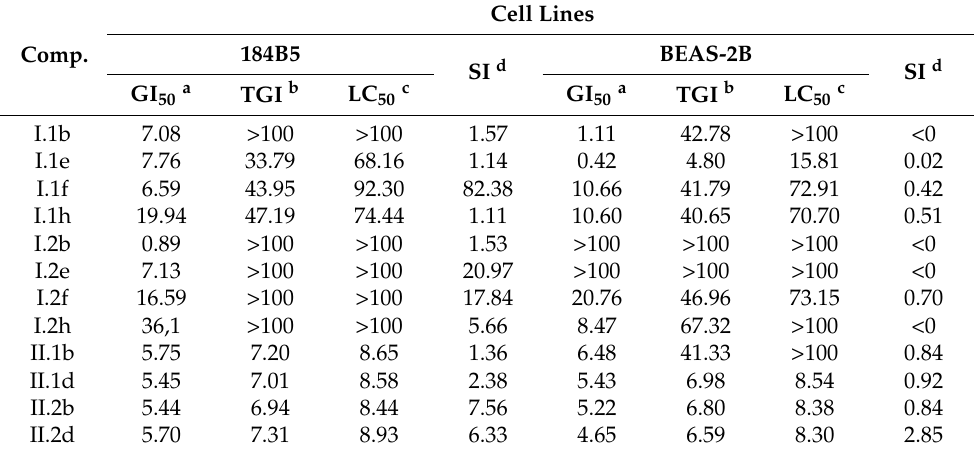
Table 2. Average ± SEM values for GI 50 , TGI and LC 50 parameters in 184B5 and BEAS-2B cell lines and selectivity indexes